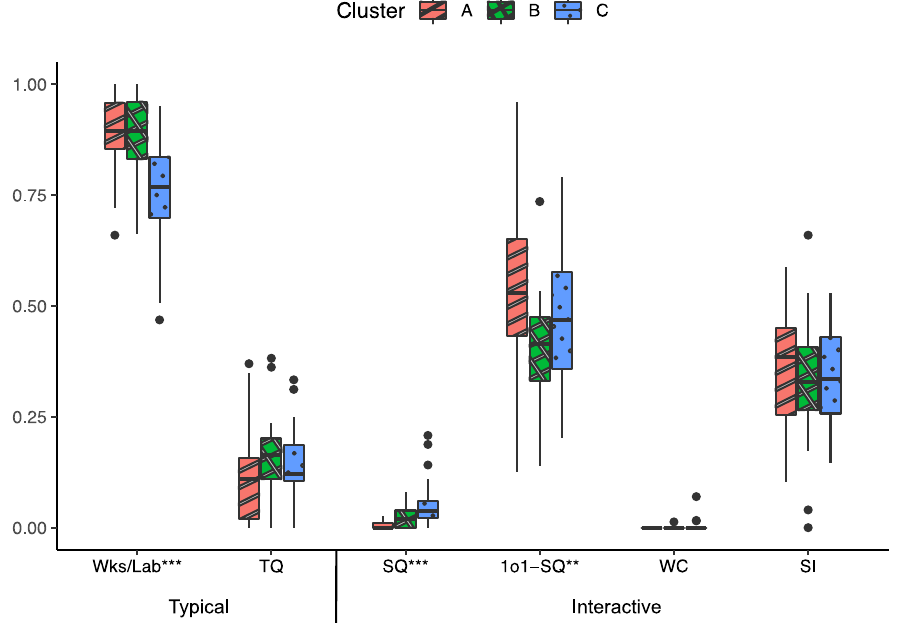
FIG. 5. Fraction of 2-min intervals per class period for each student code in each cluster. Out of 6 student codes, 3 codes are statistically significant between clusters. **medium effect size, ***large effect